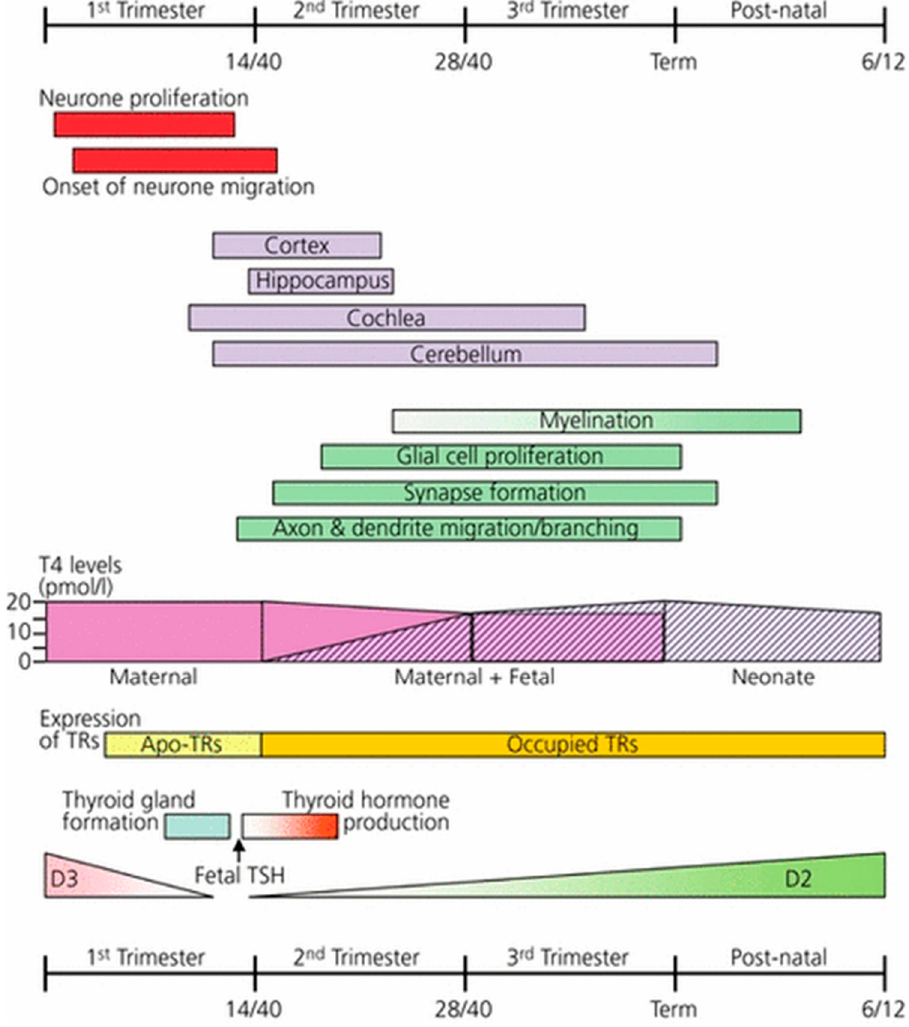
Figure 1. Thyroid hormone action and the development of the brain of the foetus and infant. Relationship between thyroid hormone action and the development of the brain. In the first trimester of pregnancy early neuronal proliferation and migration is dependent on maternal thyroxine (T4). In foetal tissues, inactivating type 3 deiodinase (D3) enzyme expression falls and the development of the thyroid gland commences. By the end of the first trimester, the development of the hypothalamic–pituitary axis has occurred and a surge in thyroid-stimulating hormone (TSH) secretion results in the onset of foetal thyroid hormone production, expression of the activating type 2 iodothyronine deiodinase enzyme (D2) and increasing occupation of thyroid hormone receptors (TRs) by 3,5,3 ¢-L-triiodothyronine (T3). Continuing the development of the brain in the second and third trimesters relies increasingly on T4 produced by both the foetus and mother. Continued post-natal development is entirely dependent on neonatal thyroid hormone production. Apo-TR, unliganded unoccupied thyroid hormone receptor. Reproduced with permission: Williams G.R., Journal of Neuroendocrinology 2008, Vol 20, 784–794, Wiley